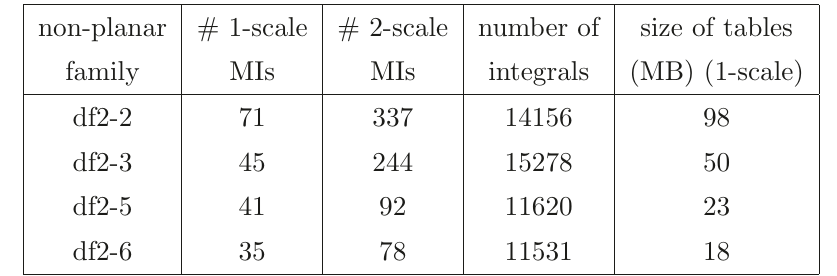
Table 1 . Information about the non-planar